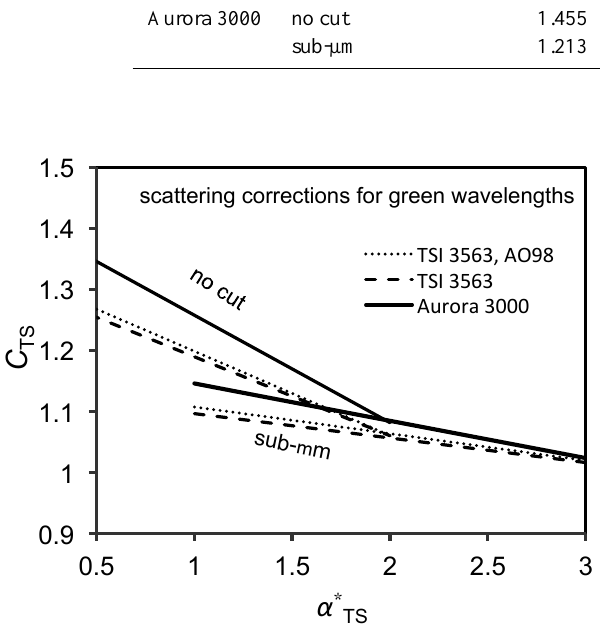
Fig. 5. Total scattering correction functions for the green wave- lengths. Shown are two branches for no cut and sub-µm